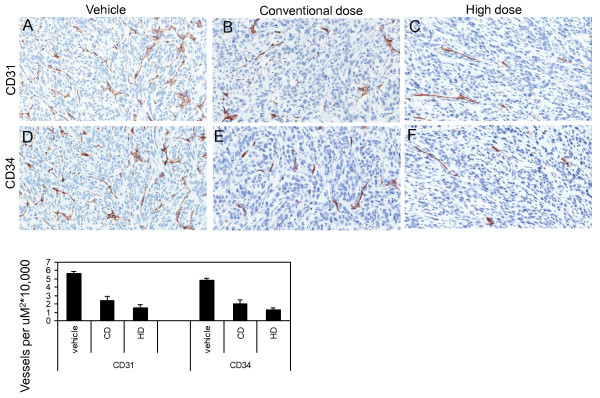
Microvessel density analysis of sorafenib treated tumors. Immunohistochemical analysis of CD31 (A-C) and CD34 (D-F) expression in vehicle (A, D), low dose (B, E) and high dose (C, F) at day3 are shown. The bar graph shows the average CD31 and CD34 expression in the vehicle (n = 3), conventional dose (n = 3), and high dose (n = 3) arms. As compared to vehicle treated tumors, the tumors exposed to conventional and high dose sorafenib had lower MVD (CD34 and CD31)(P < 0.01). There was a consistent trend for lower MVD in the high dose treatment as compared to the conventional dose treatment in both the CD34 and CD31 analyses.